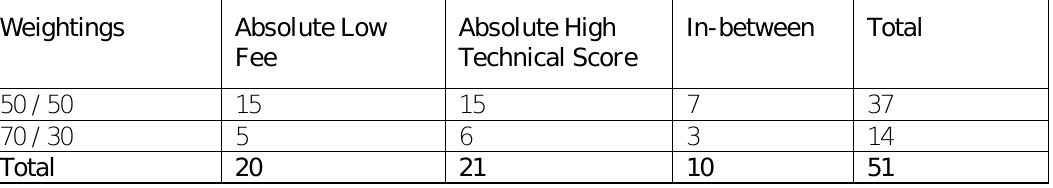
Table 3: Effect of predetermined weightings on optimum bid strategy outcome Weightings